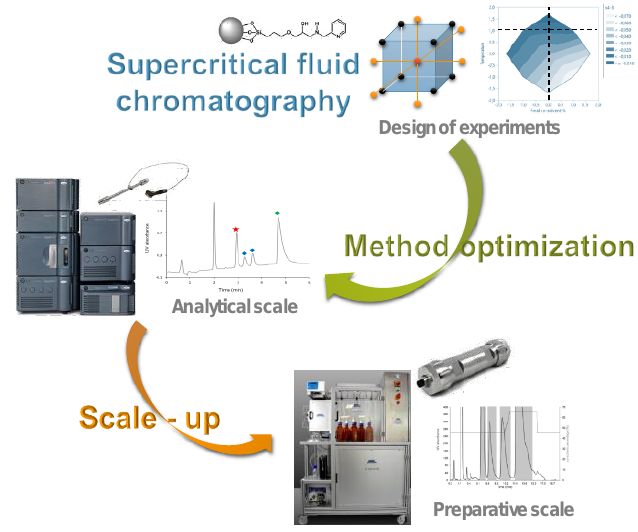
Figure 3. General applications of SFC.